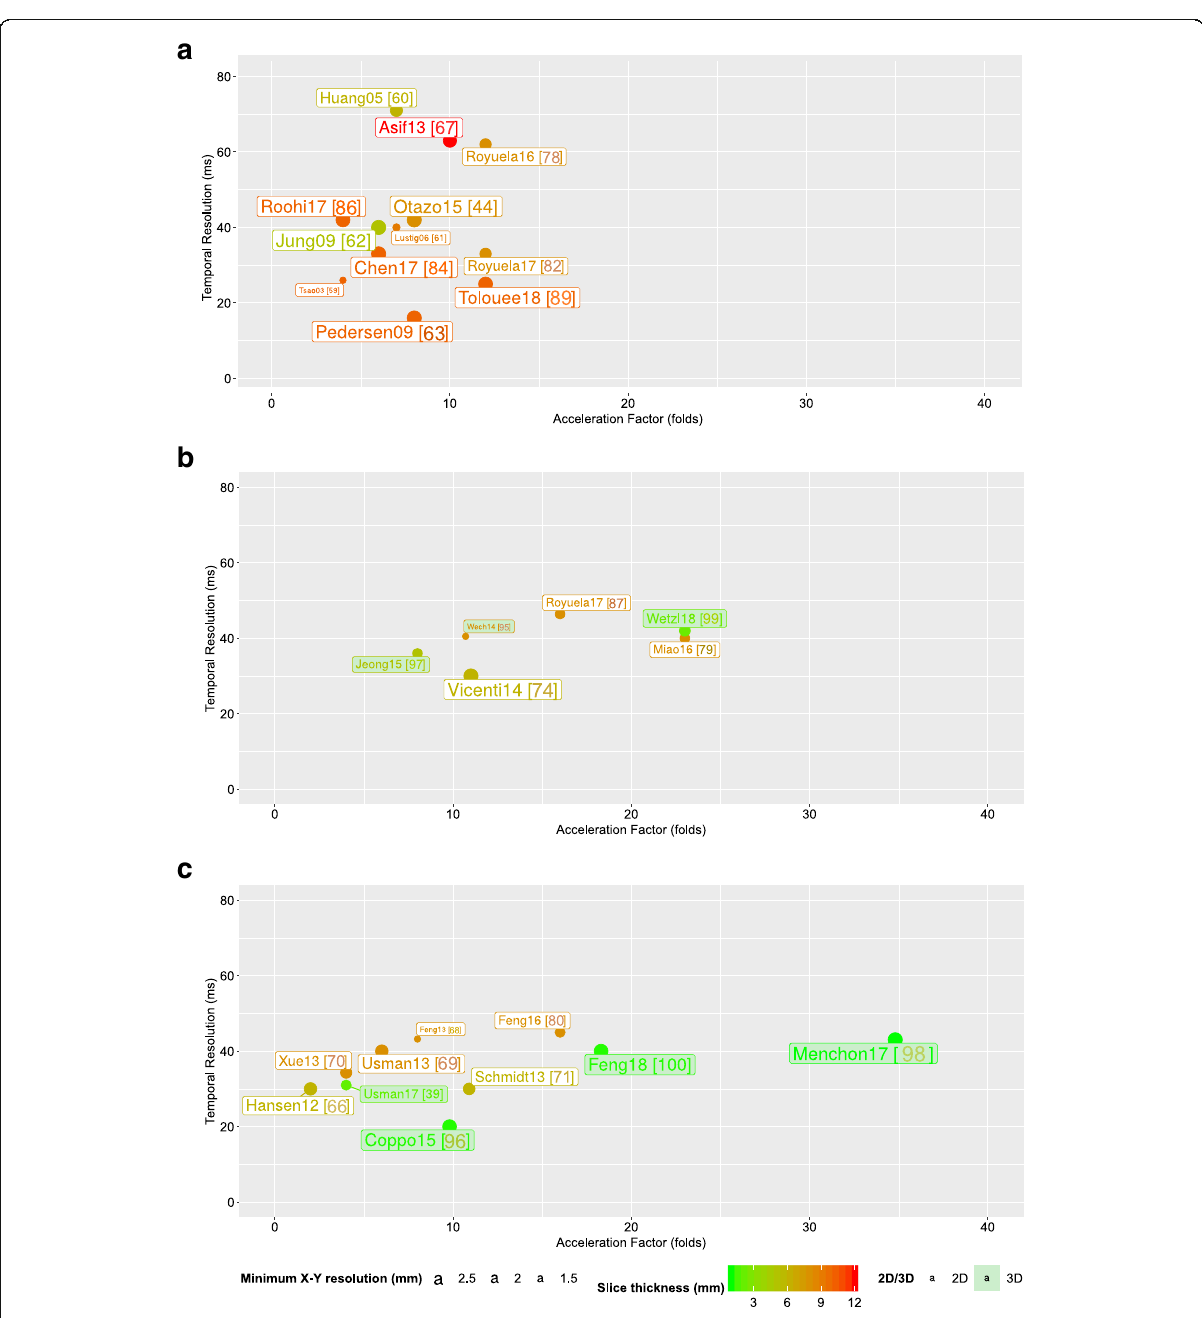
Fig. 3 Graphical representation of performance. a Multi-BH reconstruction techniques. b Single-BH reconstruction techniques. c FB reconstruction techniques. Temporal resolution (ms) versus AF. Text boxes indicate first author, publication year, and reference in brackets. Shaded text boxes refer to 3D approaches. (Lowest) in-plane spatial resolution (mm) is codified varying the size of font and markers. Slice thickness (mm) is depicted using a color